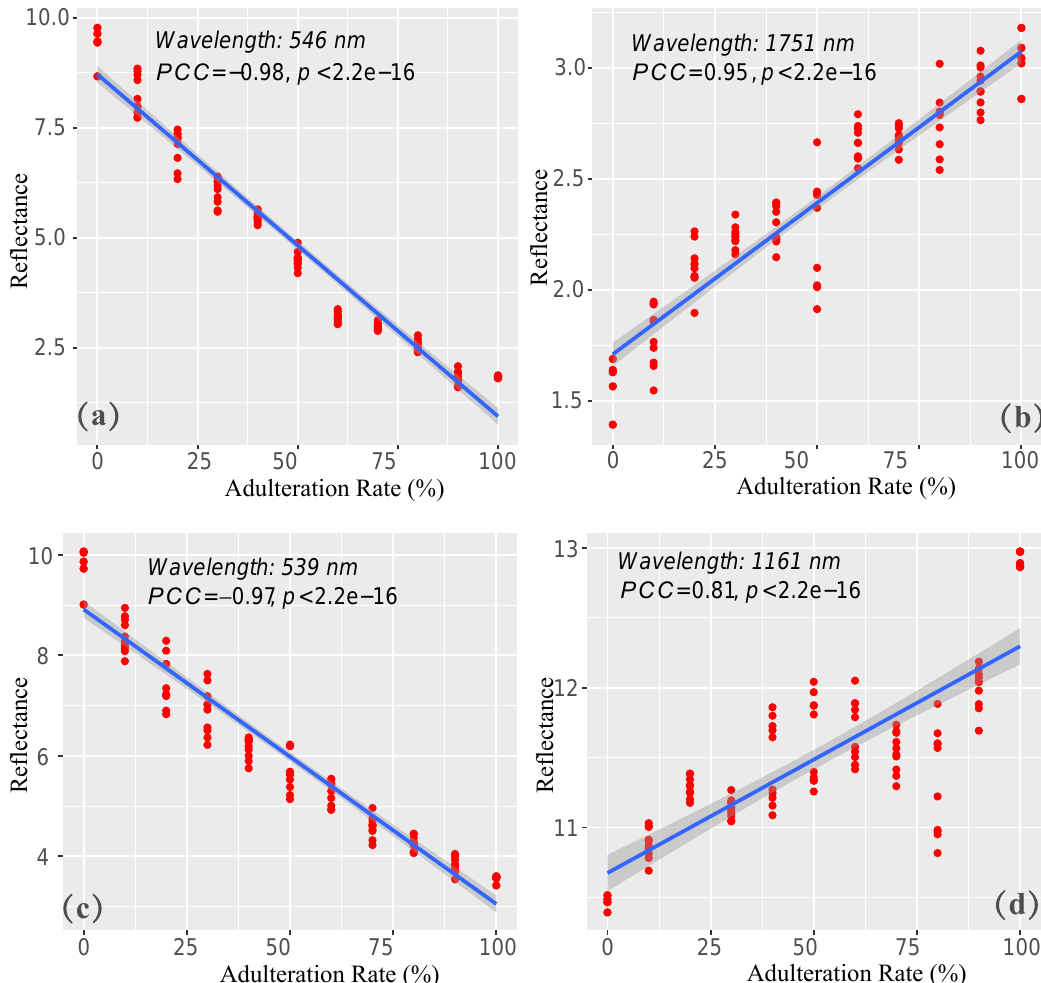
Figure 7. The correlation analysis of the adulteration rates and the reflectance of individual wavelength. The scatter plot of the adulteration rates and the reflectance at the wavelength 546 nm ( a ) and 1751 nm ( b ) in sesame oil adulterated with soybean oil, respectively. The scatter plot of the adulteration rates and the reflectance at the wavelength 539 nm ( c ) and 1161 nm ( d ) in rapeseed oil adulterated with soybean oil, respectively. (The PCC and the p-value of the corresponding significance testing were provided in each of the figures. The red dots are the oil samples, and the blue line is the fitting line of data points in each of the